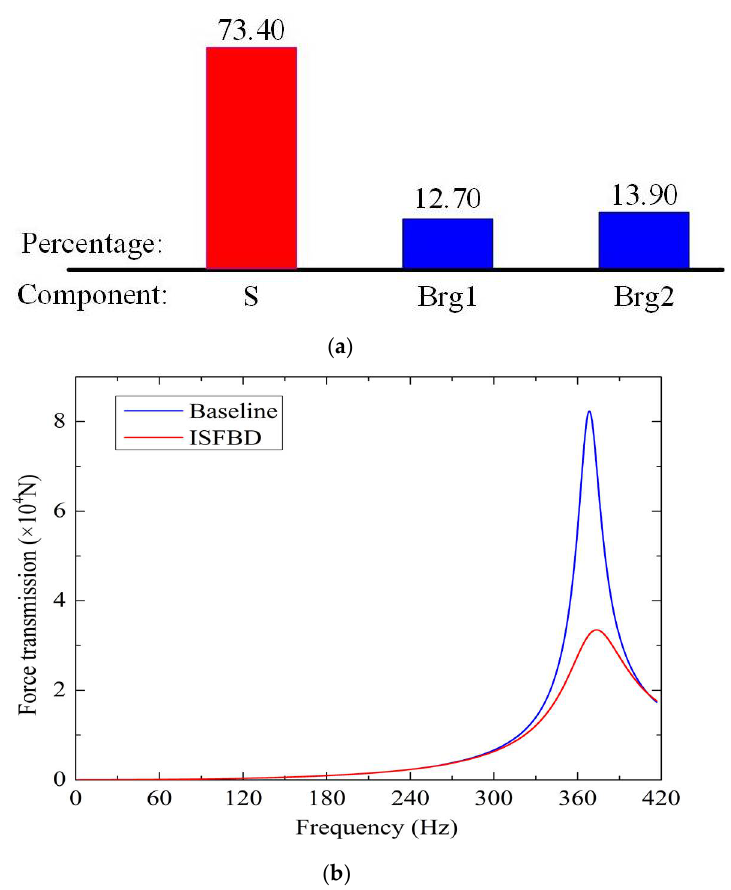
Figure 16. Vibration control performance of the optimized ISFBD: ( a ) Energy distribution; ( b ) Figure Force transmission.